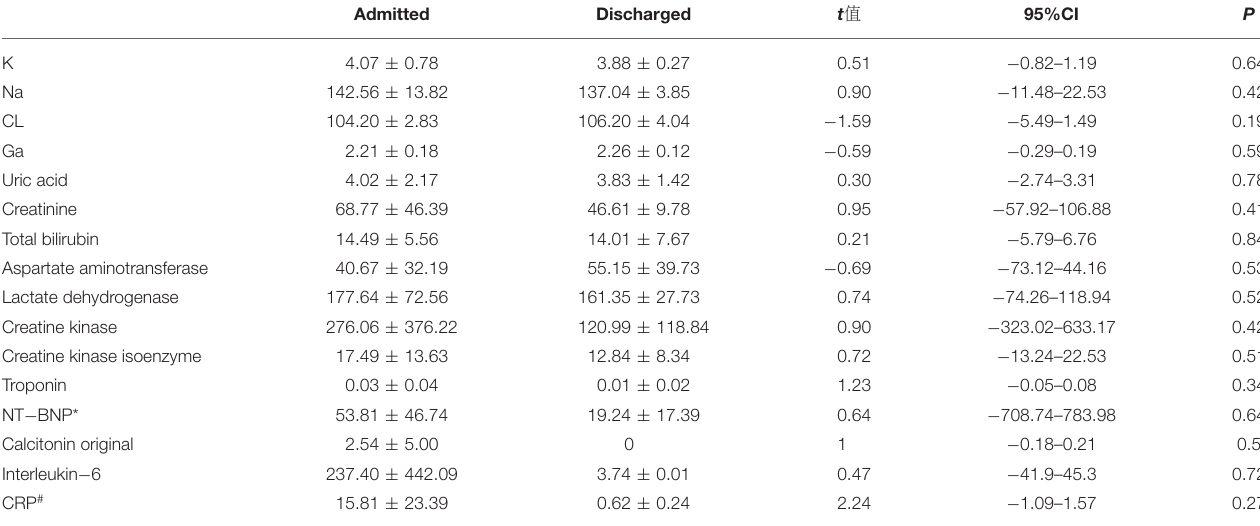
TABLE 4 | Comparative analysis of biochemical indexes of 5 patients before and after